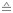
MC–PC inhibition is frequency dependent.(A) Expression of AAV-DIO-ChR2-EYFP (green) in MCsα2 (red) in a primary auditory cortical slice used for optogenetic stimulation, with inset on L5 showing overlap of membrane expression in yellow (scale bars 50 μm). (B) Optogenetic activation (3-ms light pulses, 488 nm) of a group of MCsα2 induced IPSPs in type A PCs (left) but not type B PCs (right) (n = 12 cells, single examples in grey, mean in black). (C) Example traces show MCsα2 responses to blue light stimulation at various frequencies (3-ms blue light pulses at 2, 5, 15, 25, 40, and 70 Hz) and the corresponding IPSPs in a nearby type A PC (n = 12 cells, single examples in grey, mean in black). At higher frequencies (≥15Hz), the MCα2–PC synapse showed depression. Note that MCsα2 could not follow 70-Hz light stimulation for prolonged time. (D) Top: Continuous light stimulation of MCsα2 (500 ms) generated large type A IPSP amplitudes (middle; n = 12 cells, single examples in grey, mean in black) similar in magnitude to IPSPs generated by high-frequency stimulation at 70 Hz. Bottom: Spike-frequency adaptation of MCsα2 is shown as a function of time (see also S3B–S3D Fig). (E) Mean IPSP amplitudes in type A PCs following stimulation of MCsα2 at different frequencies (from (C) and (D); 2 Hz: −1.57 ± 0.13 mV, 5 Hz: −1.70 ± 0.08 mV, 15 Hz: −3.05 ± 0.12 mV, 25 Hz: −3.20 ± 0.13 mV, 40 Hz: −3.76 ± 0.10 mV, 70 Hz: −4.37 ± 0.10 mV, 500 ms: −4.41 ± 0.07 mV; 2, 5 Hz versus 15, 25 Hz ≙
p < 0.0001; 15, 25 Hz versus 40 Hz ≙
p < 0.0001; 40 Hz versus 70 Hz, 500 ms ≙
p < 0.001; mean ± SEM, ANOVA, n = 12 cells, S3 Data).